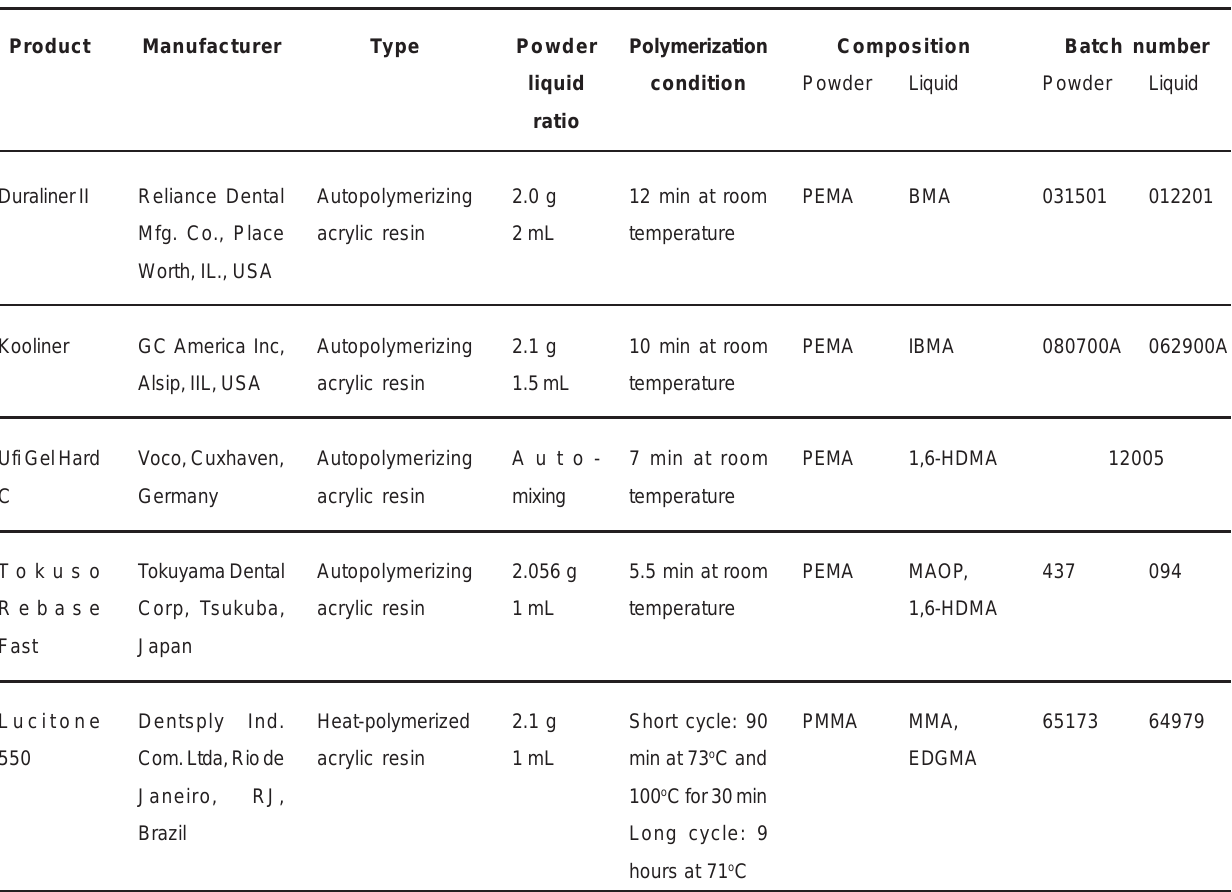
TABLE 1- Materials used in this study